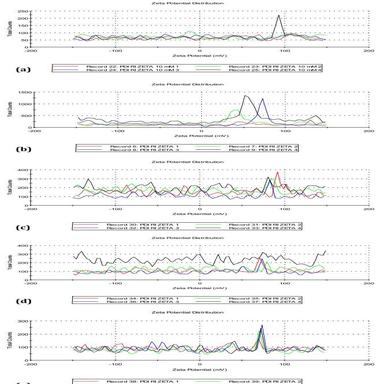
(a)–(e): Zeta(ζ) potential distribution of 10 mM DMPI at 5 different temperatures (293 K, 298 K, 303 K, 308 K & 313 K respectively) in aqueous solution.